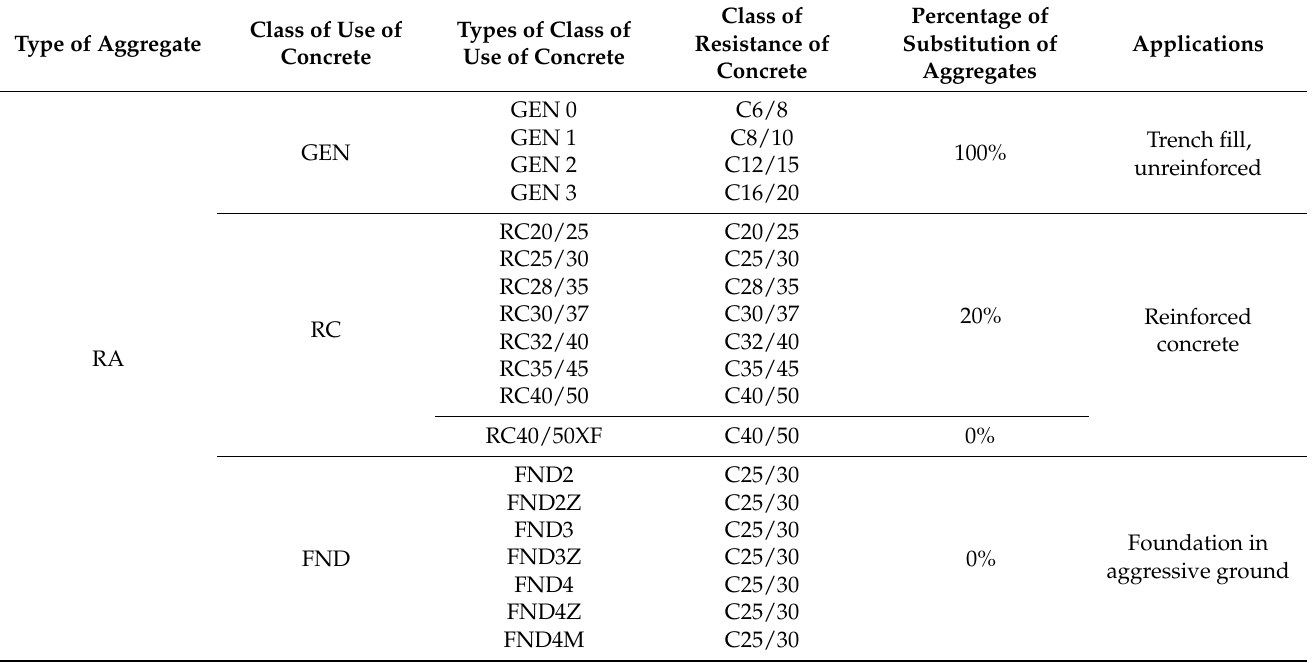
Table 7. Percentage of substitution according to British standards (BS 8500-2)